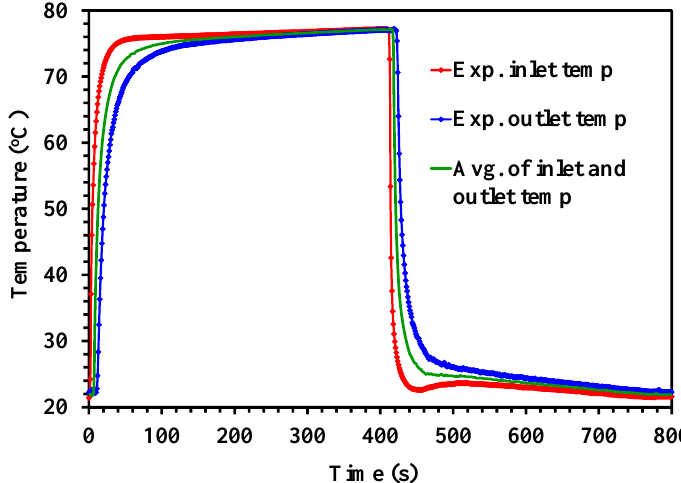
Figure 4. Water source temperature profiles at the inlet (red) outlet (blue) and middle tube (green).